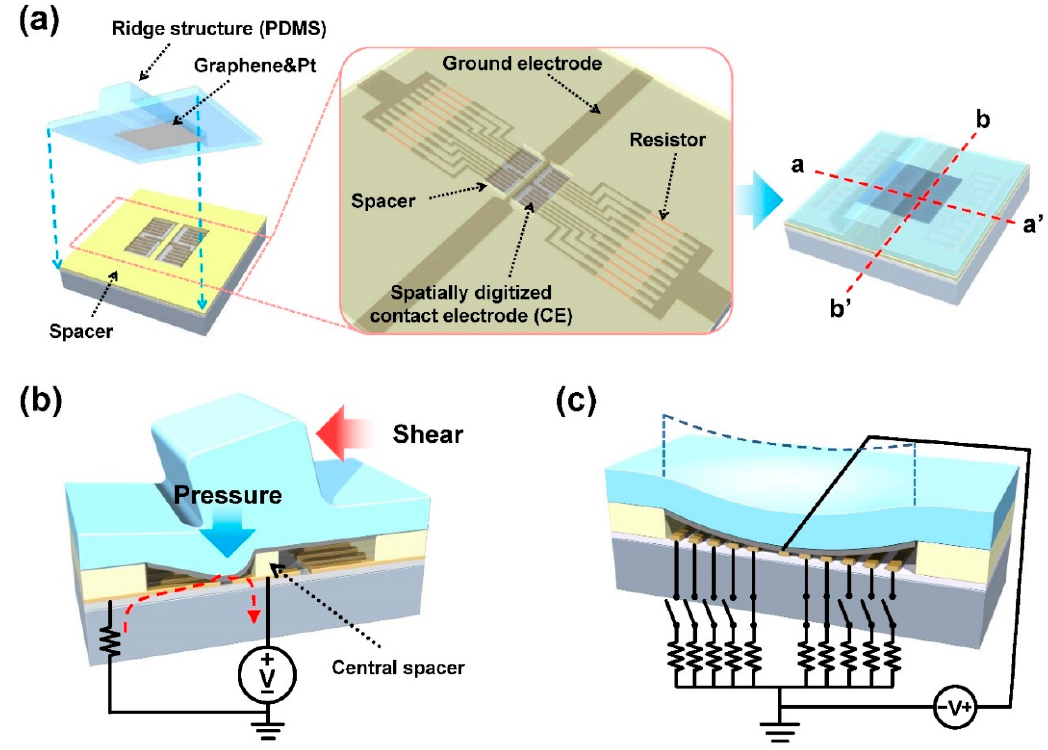
Figure 1. Schematic illustration and operating mechanism of the tactile shear sensor: ( a ) schematic diagram of the sensor; ( b ) 3D cross-sectional image along a-a’ in ( a ), showing the shear sensing mechanism; ( c ) 3D cross-sectional image along b-b’ in ( a ), showing a short-circuit with multiple electrodes making contact with the graphene layer.